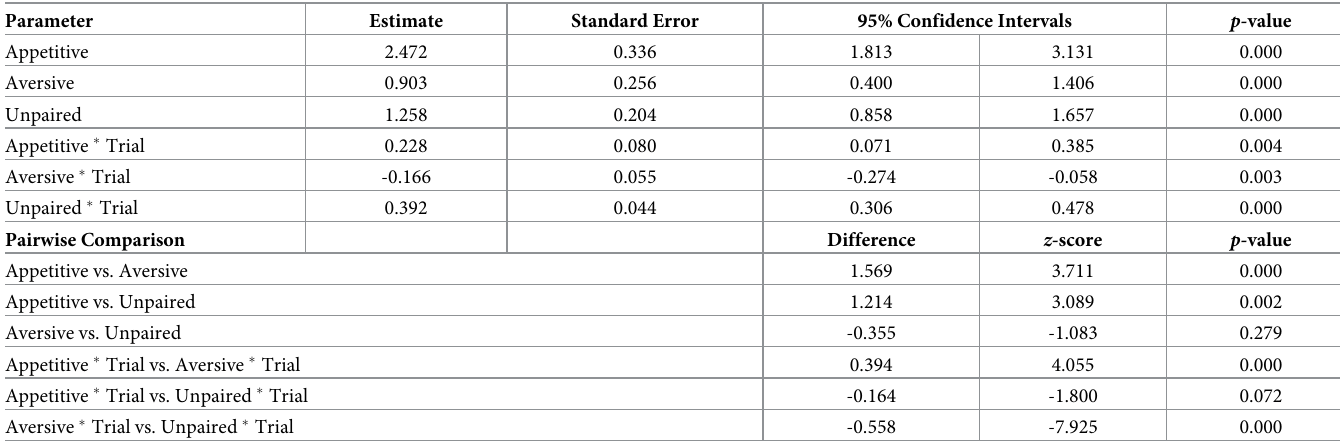
Table 3. Experiment 1 conditioning US MPR duration.